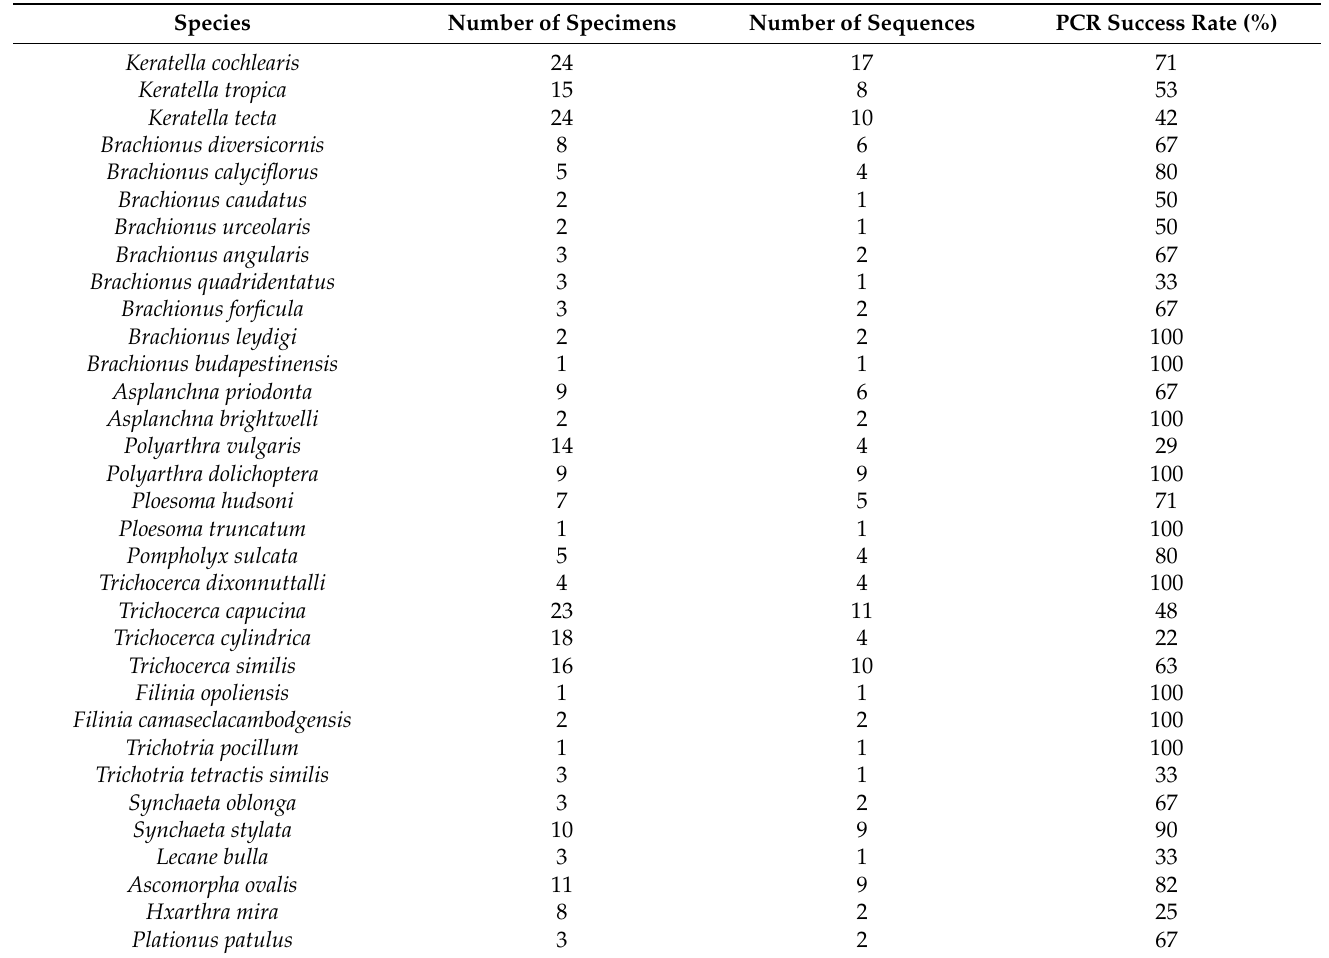
Figure 2. Venn diagrams, “Quantitative”: the numbers of species identified with quantitative samples; “Qualitative”: the numbers of species identified with qualitative samples; “DNA Barcodes”: the number of species obtained mtCOI barcodes. Table 1. PCR success rates for species that had at least one successful